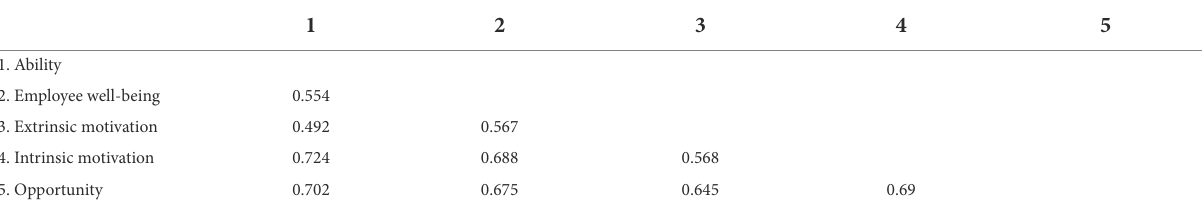
TABLE 4 Discriminant validity (HTMT